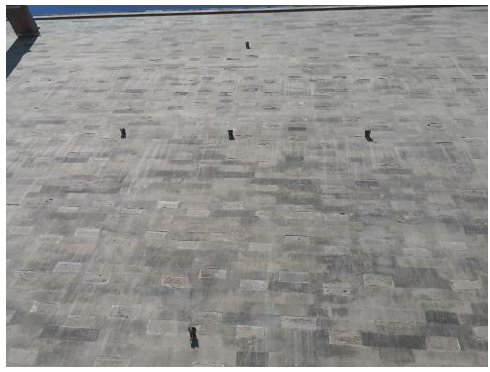
Figure 4. Layout of observation